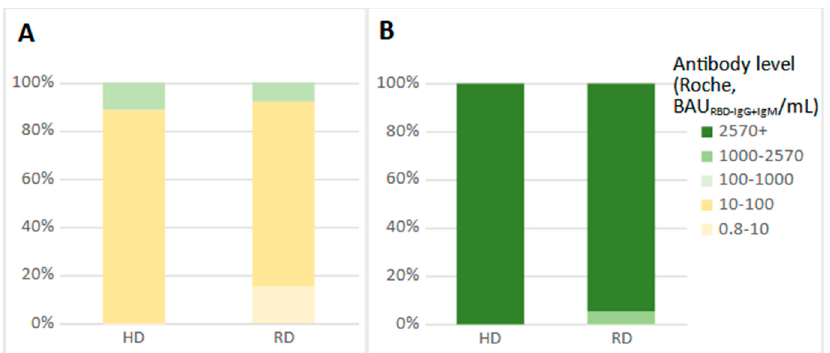
Figure 2. Comparison of antibody levels in the HD– and RD–COVID–19–positive subgroups before vaccination ( A ) and 8 days after the first vaccine dose ( B ). vaccination ( A ) and 8 days after the first vaccine dose ( B